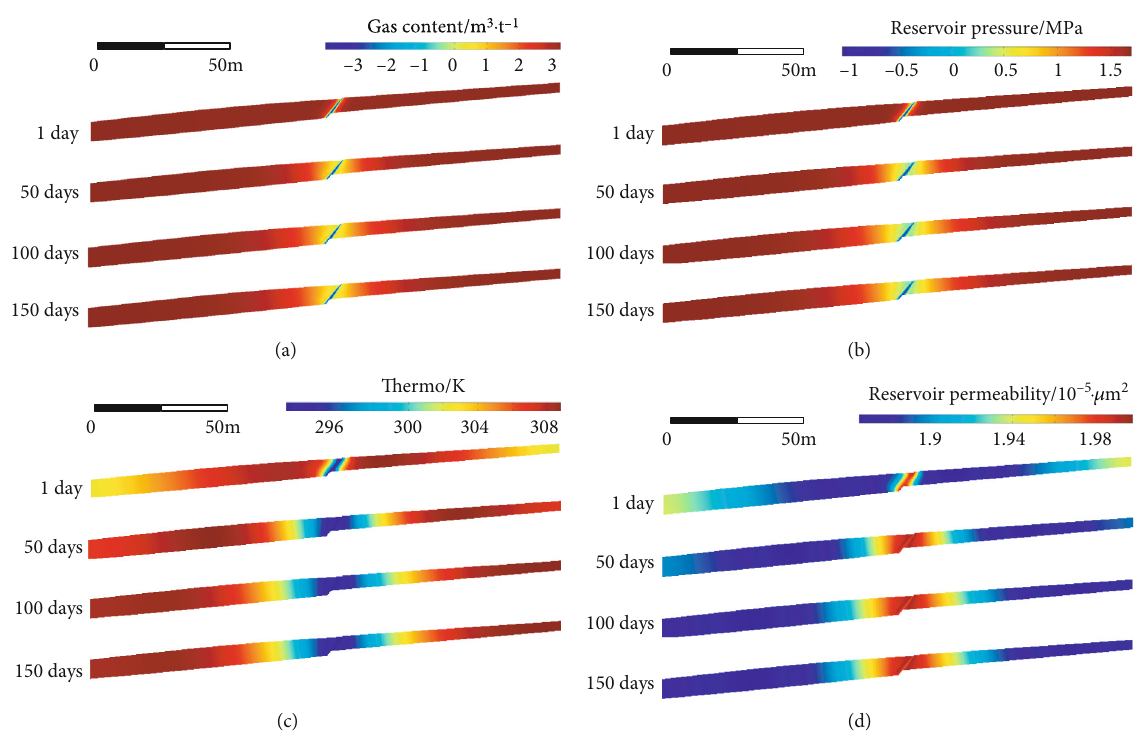
Figure 9: Multi fi eld evolutionary characteristics of THM near the F11 normal fault